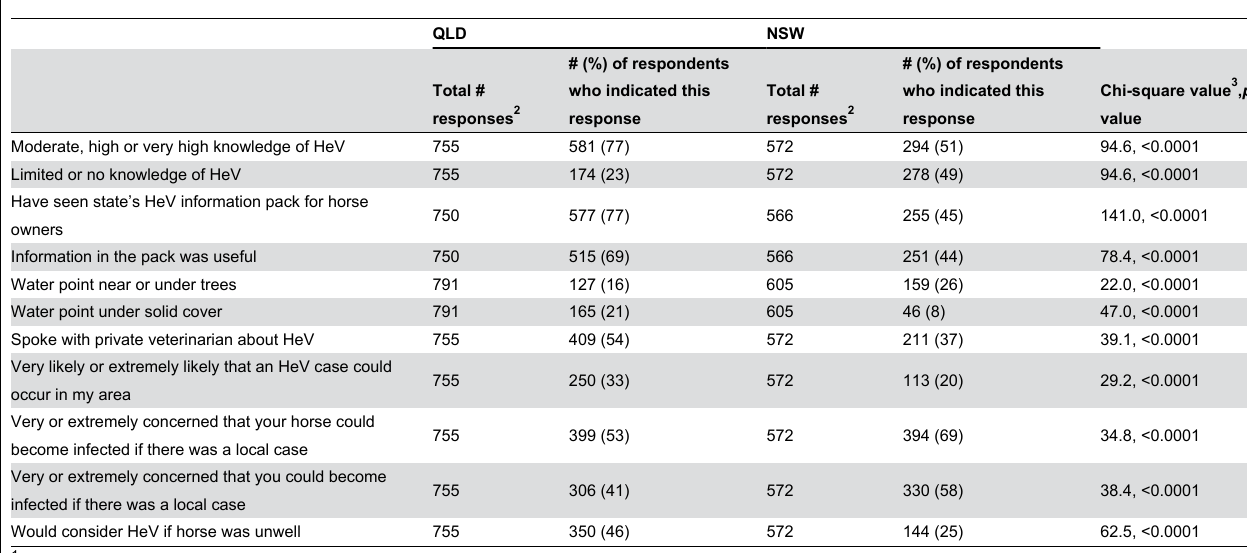
Table 2. Hendra virus knowledge 1 , risk perception and risk management among survey